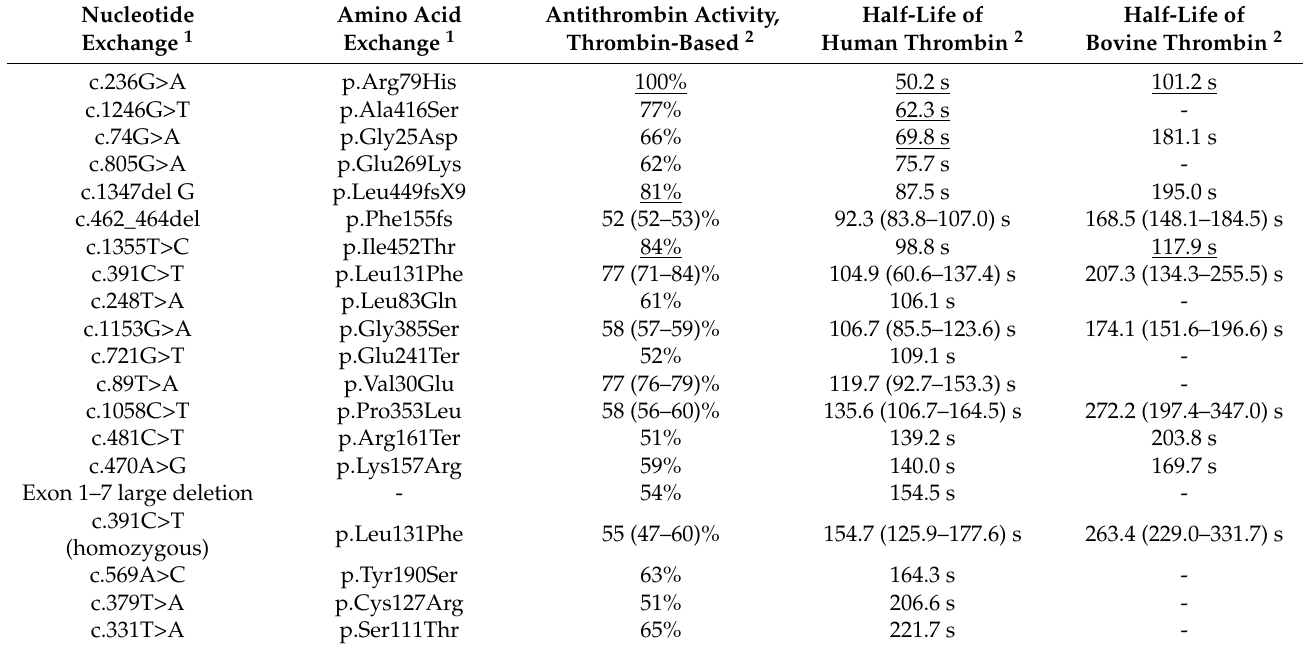
Table 2. Plasma half-life of human or bovine thrombin according to antithrombin mutation.